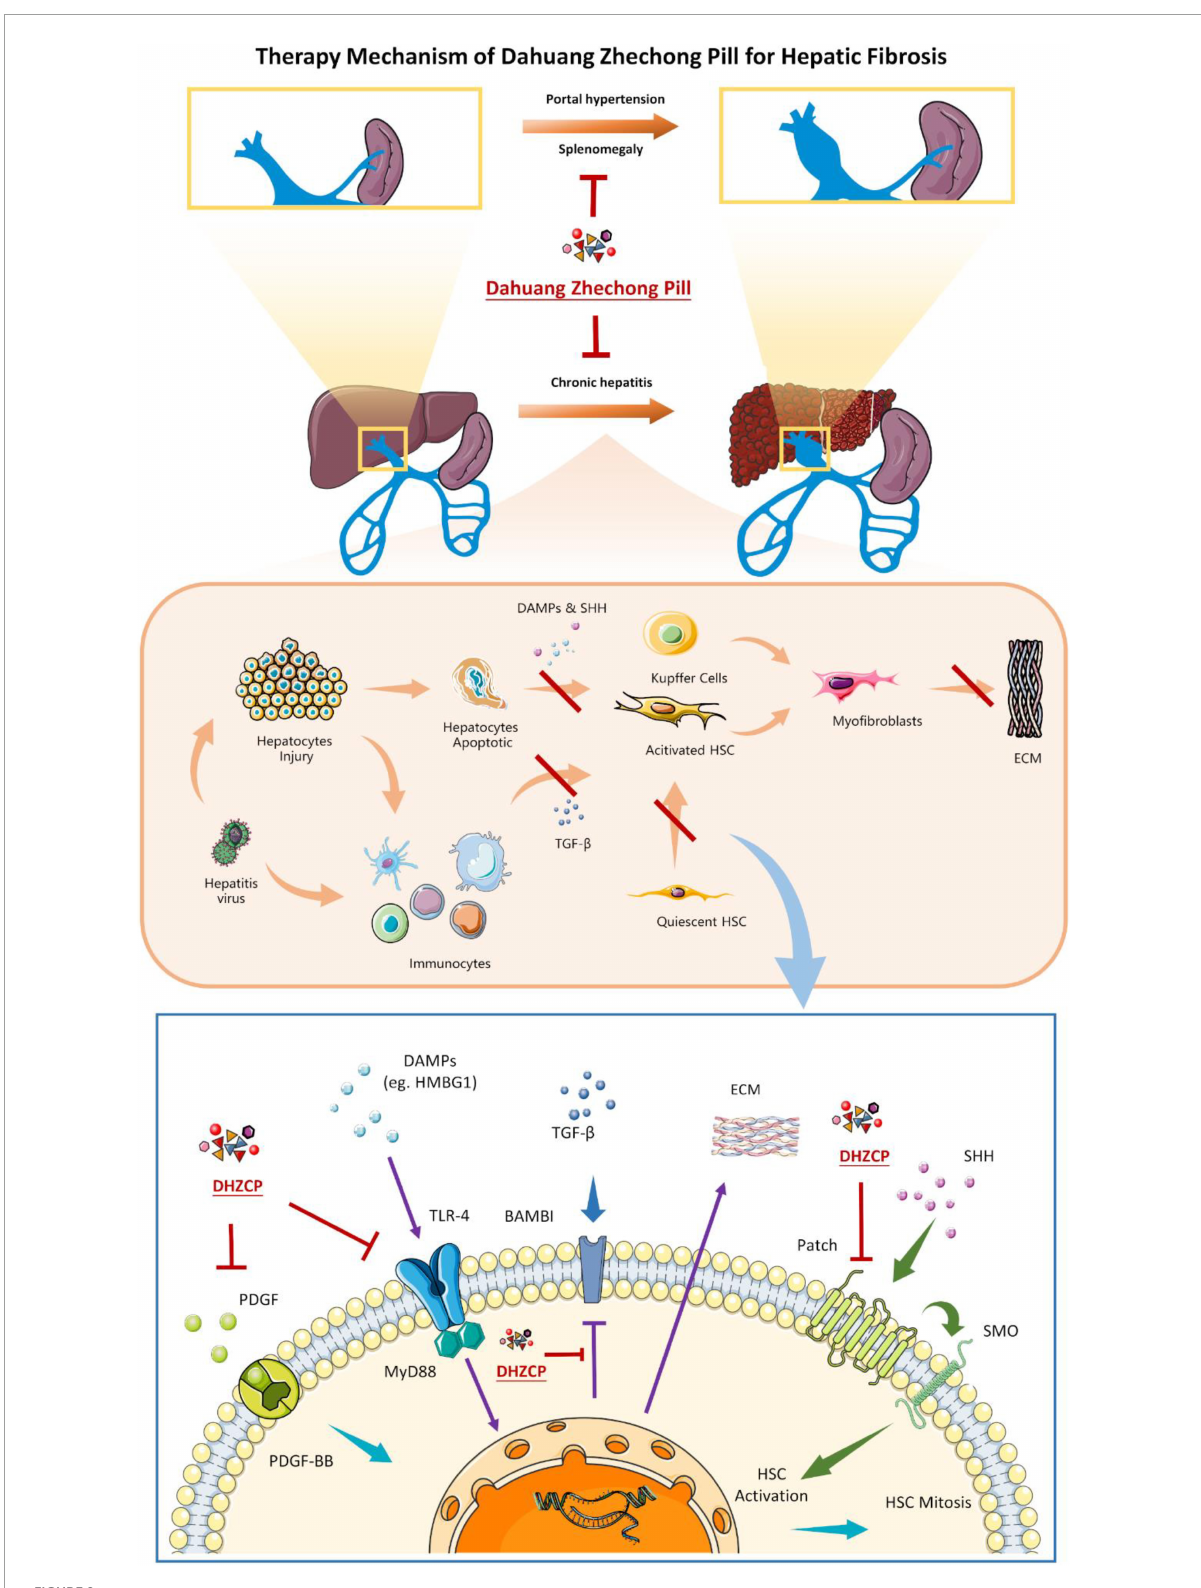
FIGURE9 The metabolism of Dahuang Zhechong pill (DHZCP) in treating hepatic fibrosis according to the reported studies. In the molecular mechanism diagram (the lowest picture) , arrows with the same color indicate the same signaling pathway.